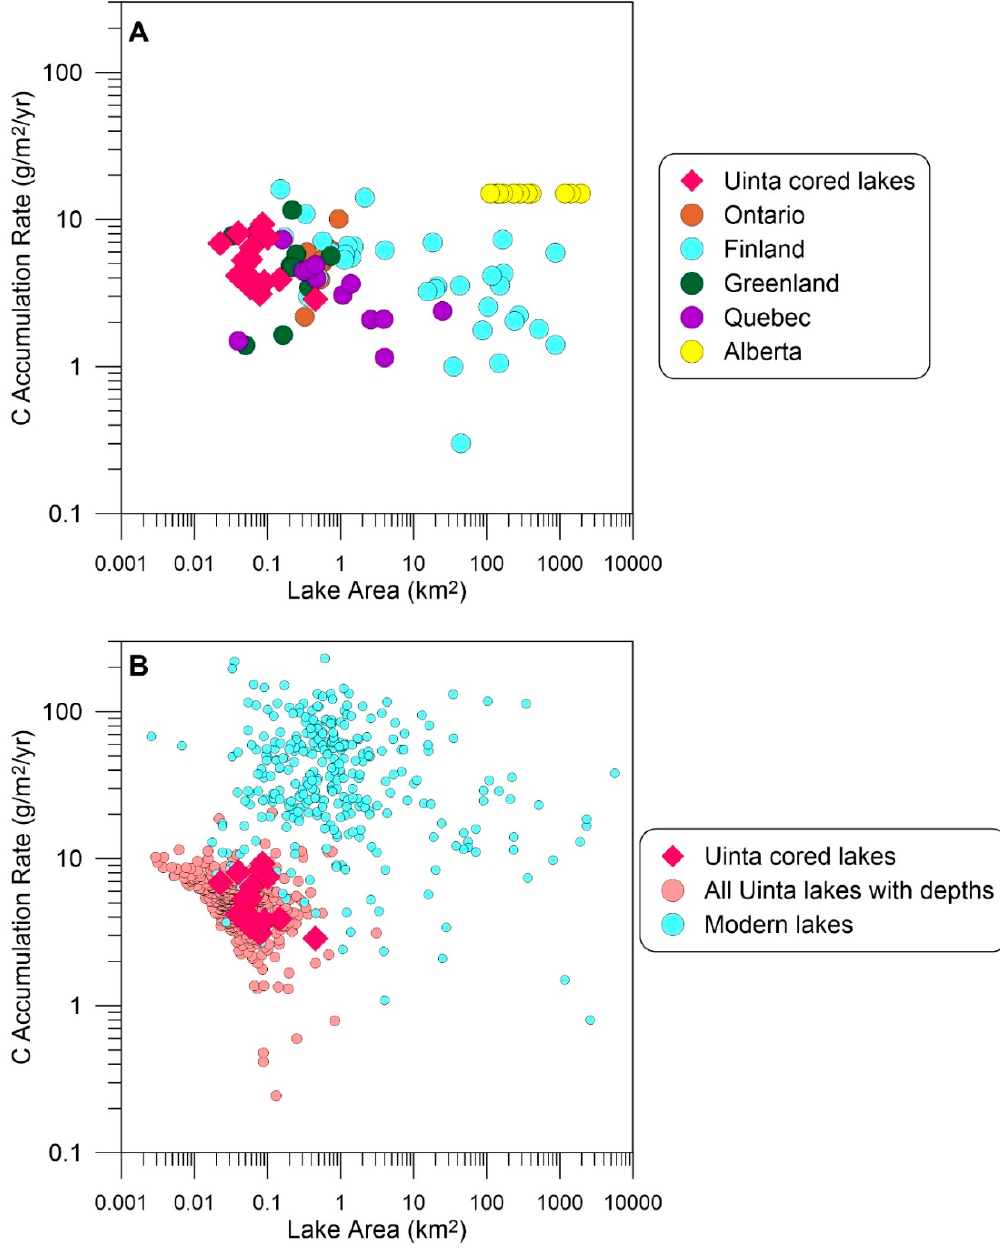
Figure 9. Plots of lake area and carbon accumulation rate. ( A ) Log-log plot of lake area vs. carbon accumulation rate for studies based on Holocene-length records. Uinta lakes have rates more similar to those of lakes in locations much farther north. ( B ) Log-log plot (same axis dimensions) of carbon accumulation rates in Uinta lakes (measured and estimated) and modern sedimentation rates in a recent global compilation [15].